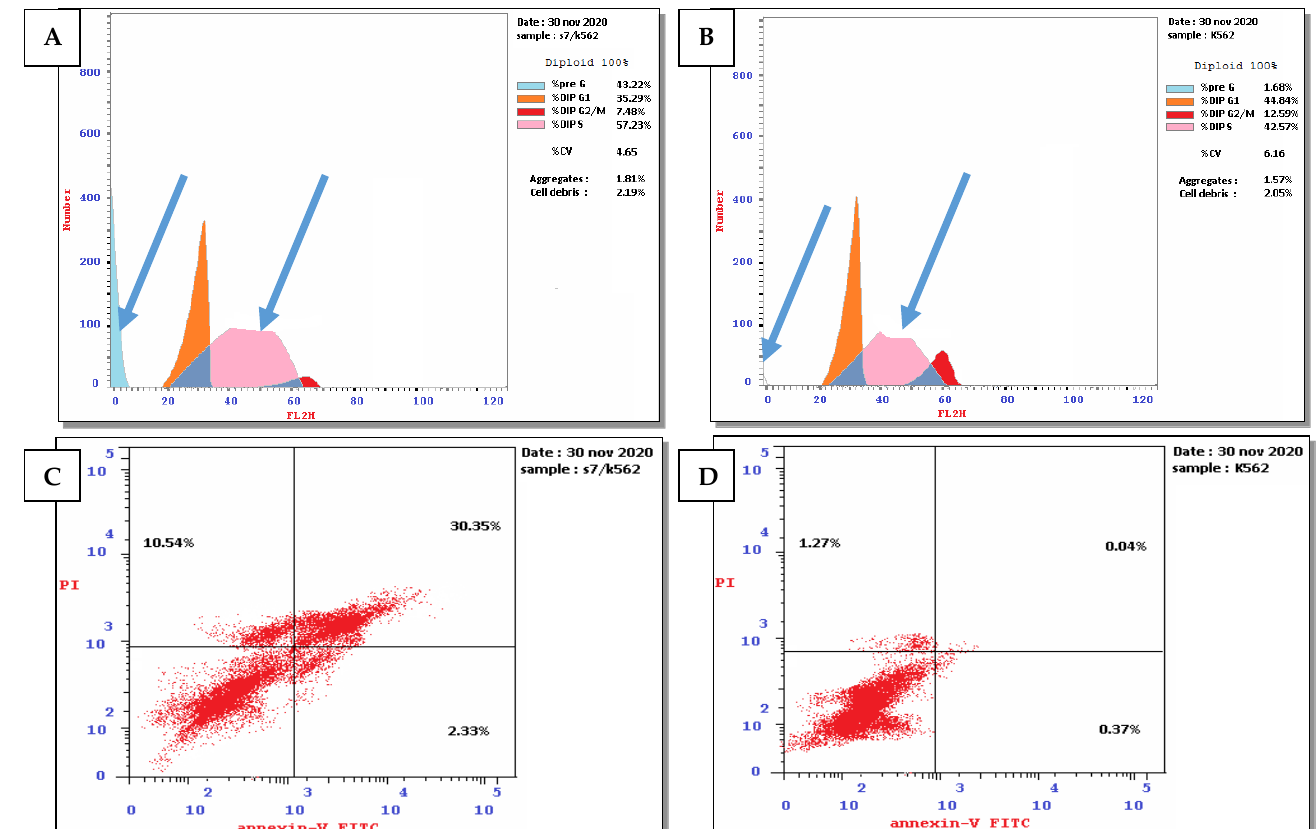
Figure 4. ( A ) Effect of compound 3 on the cell cycle distribution of leukemia cell line K562. ( B ) Untreated leukemia cell was used as negative control. ( C ) Apoptosis induced by compound 3 using leukemia cell line K562. ( D ) Apoptosis in untreated cells as a negative control. The four quadrants identified as: lower left: viable cells; lower right: early apoptotic cells; upper right: late apoptotic cells; upper left: necrotic